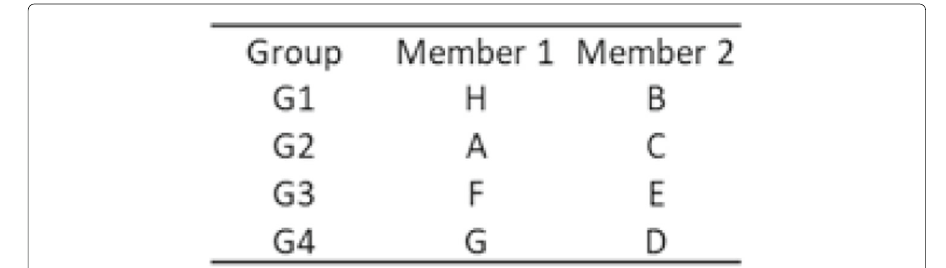
Fig. 6 A sample result of jigsaw algorithm